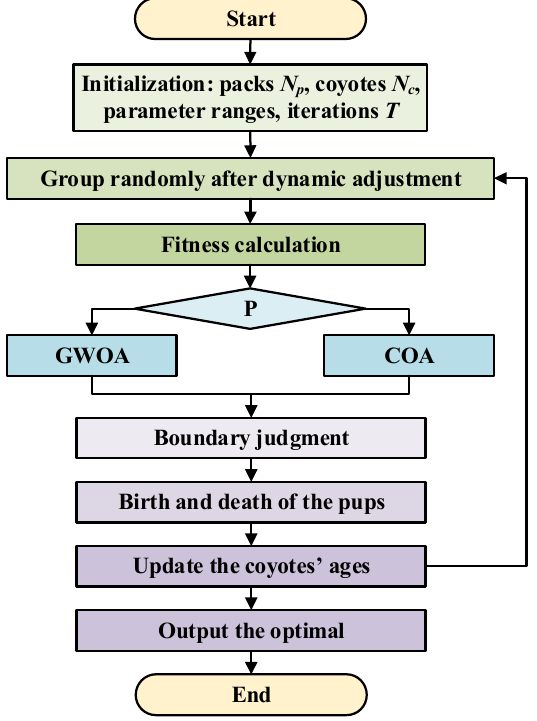
Figure 5. Flow chart of HWOA.